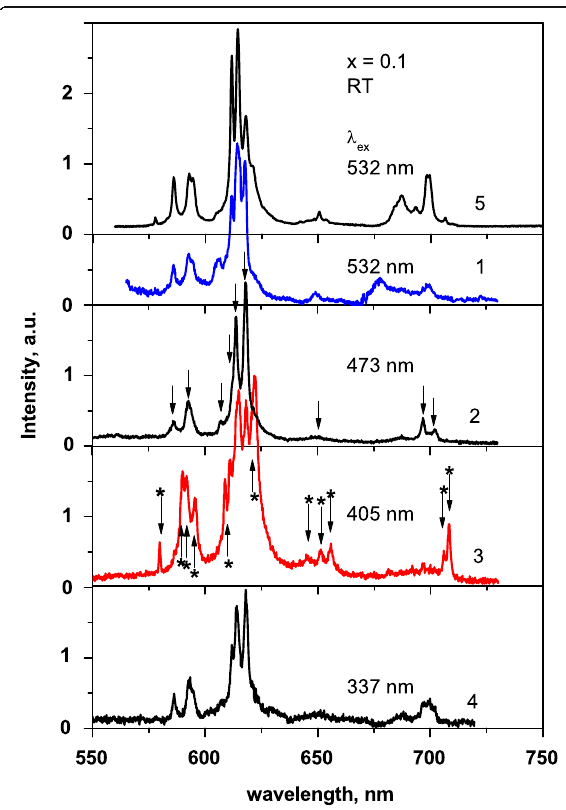
Fig. 6 Emission spectra of the La0.8Eu0.1Ca0.1VO4 ( 1 – 4 ) and La0.9Eu0.1VO4 ( 5 ) samples at λ ex = 532 ( 1 , 5 ), 473 ( 2 ), 405 ( 3 ), and 337 nm ( 4 )